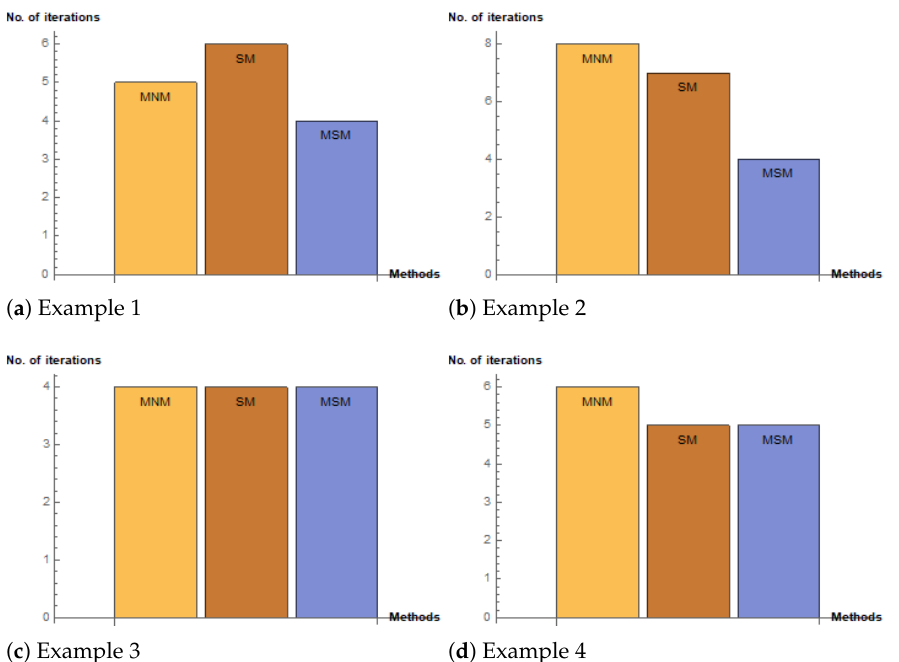
Figure 1. Graphical error analysis.